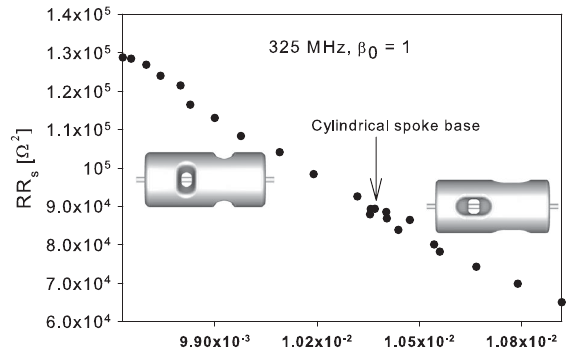
FIG. 37. Dependence of RR s on the ratio of cavity surface area to